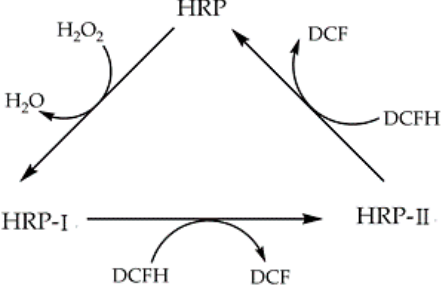
Figure 5. H 2 O 2 reacts with horseradish peroxidase (HRP), following the reaction with dichlorofluorescin (DCFH) to produce fluorescence product fluorescent compound (DCF) [31].